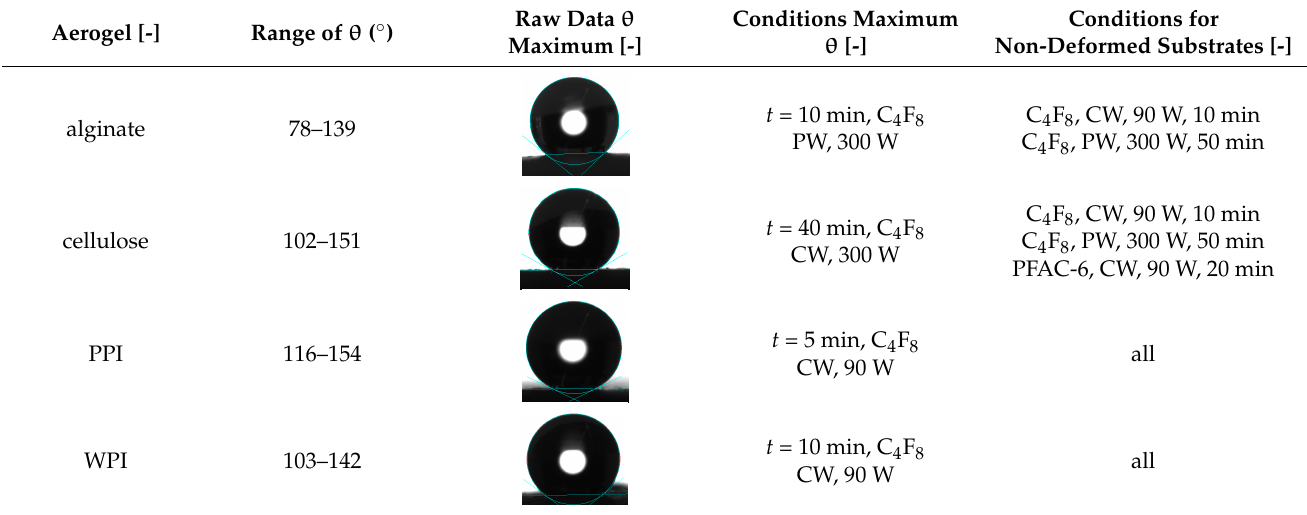
Figure 2. Static water contact angles θ depending on coating material and aerogel type. Dashed lines mark the regions of hy- drophobicity ( θ = 90–150°) to superhydrophobicity ( θ ≥ 150°). All values represent the average of successful settings n (cases 3 and 4) at different process times; error bars represent the standard deviation of the averaged values. PW (pulsed wave mode) and CW (continuous wave mode) stand for the power input mode; accordingly, numbers represent the input energy. Numbers in columns stand for the minimum process times (min) needed to achieve the corresponding case; x denotes that the corre- sponding case did not occur under the given process conditions. Table 4. Range of static water contact angles on different aerogel substrates.